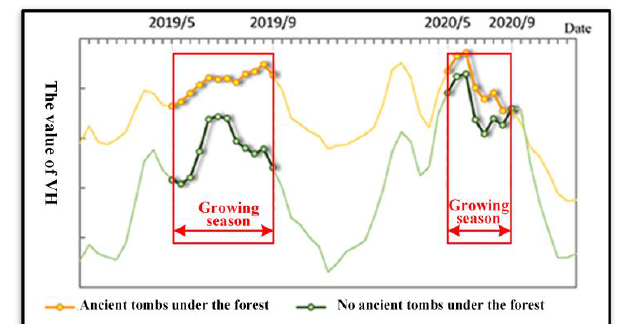
Figure 11. Timing-series features of VH.